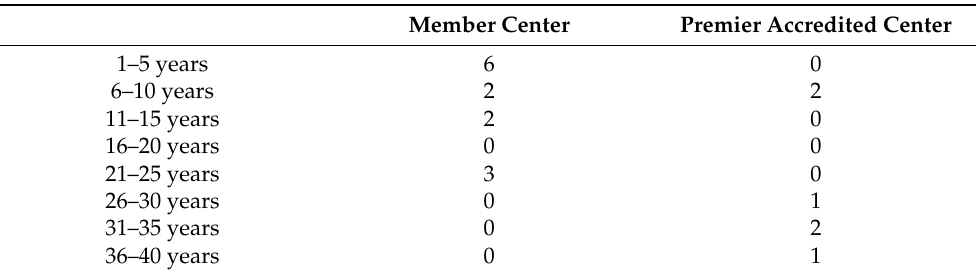
Table 1. Number of years member centers and premier accredited centers in Florida have been members of PATH Intl. (formerly NARHA). Data represent number of respondents.